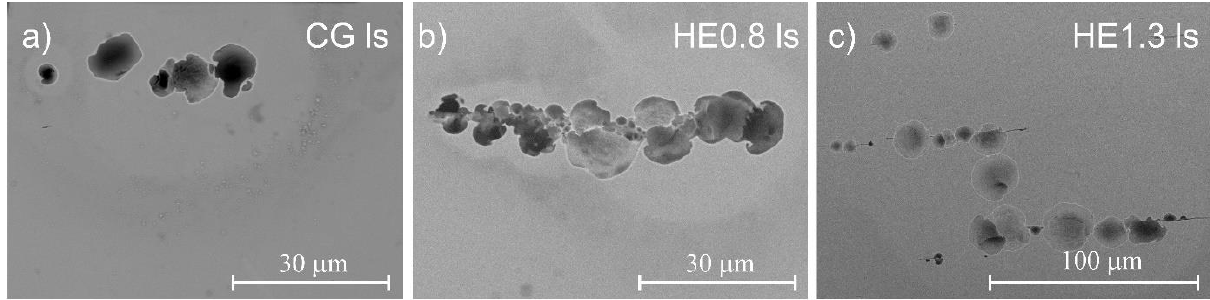
Figure 6. Post-corrosion morphology of the corrosion attack after potentiodynamic polarization in borate buffer solution with chloride ions on the cross-section of ( a ) CG, ( b ) HE0.8, and ( c ) HE1.3 samples.